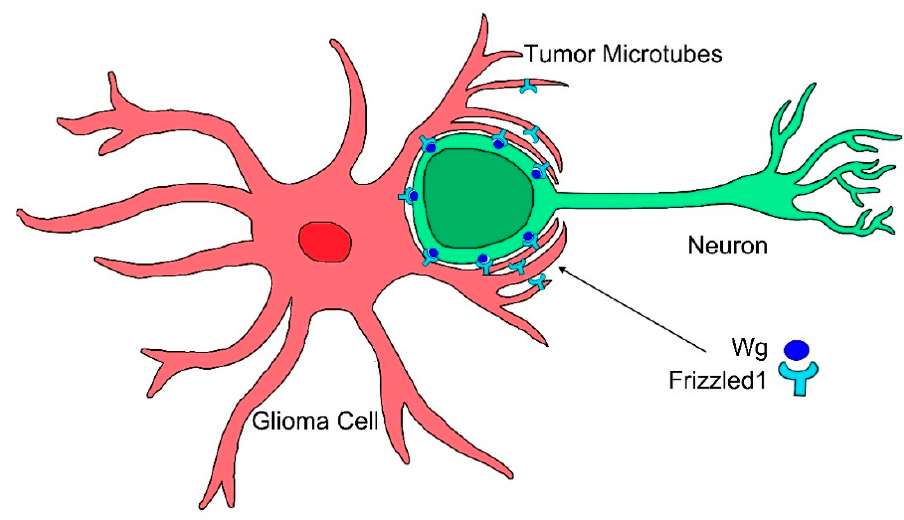
Figure 3. Cytonemes in tumorigenesis. Glioma cells produce a network of tumor microtubes that grow to reach and enwrap neighboring neurons. Increased glia-neuron membrane contacts facilitate neuronal Wg sequestering mediated by glioma Frizzled1 receptor accumulated in the tumor microtubes.